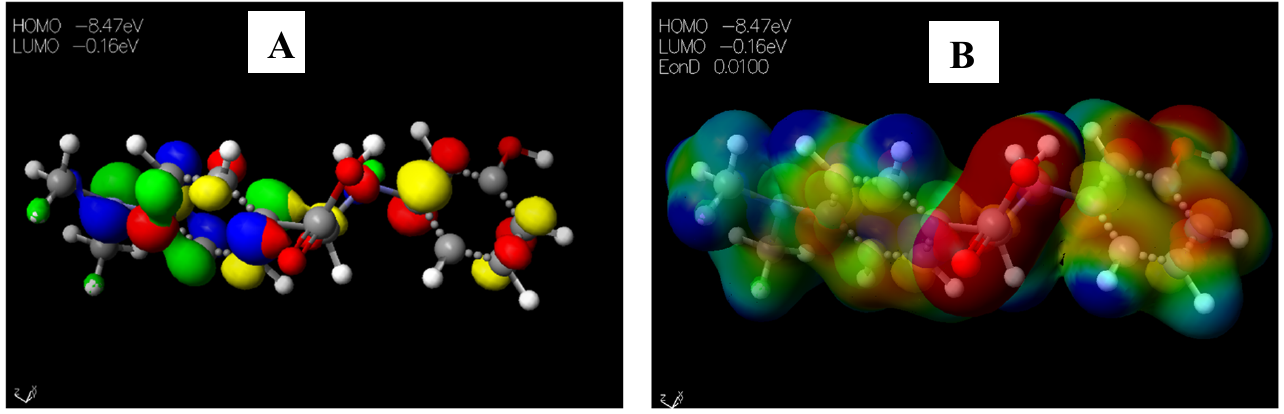
Figure 12. Images showing the ( A) Highest occupied molecular orbital (HOMO) and Lowest unoccupied molecular orbital (LUMO) and ( B ) Molecular electrostatic potential (MESP) plots of 8.